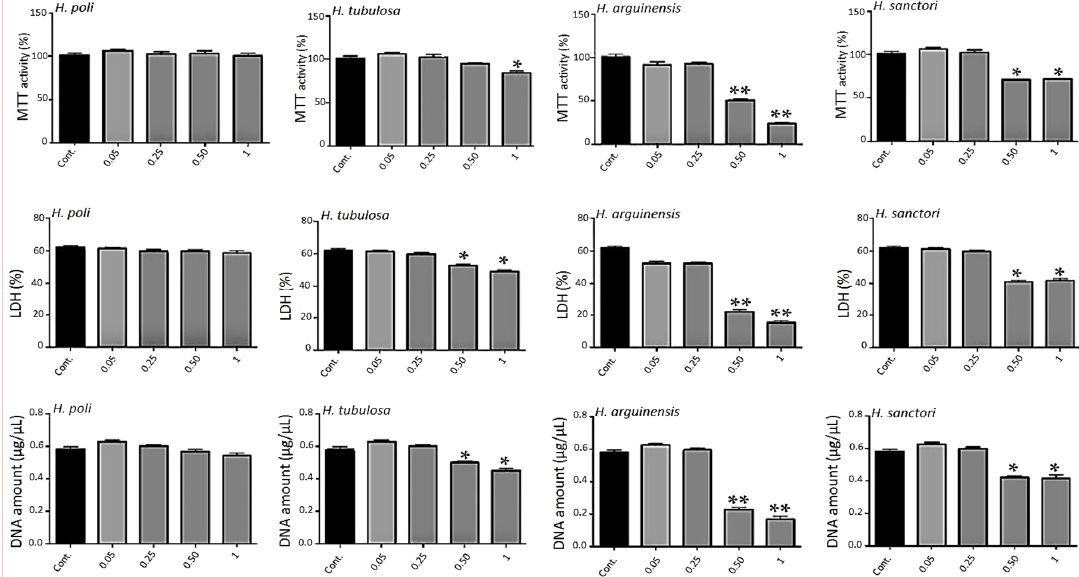
Figure 2. Impact of hydrolysates on metabolic activity. Human MSCs were exposed to increasing concentrations of hydrolysates (0.05, 0.25, 0.5 and 1 mg/mL) for 7 days. Metabolic activity was assessed using the 3-(4,5-dimethylthiazol-2-yl)-2,5-diphenyltetrazolium) (MTT) assay. Lactate Dehydrogenase (LDH) release was determined as described under the Materials and Methods section. DNA concentrations were measured to estimate the proliferation of the cells. For each tested condition, the cell metabolic activity results are presented in% versus control (Cont.) condition (100%). The error bars represent standard deviation of means ± SD of at least three individual experiments. * p < 0.01, ** p < 0.001 compared to control for each time point.